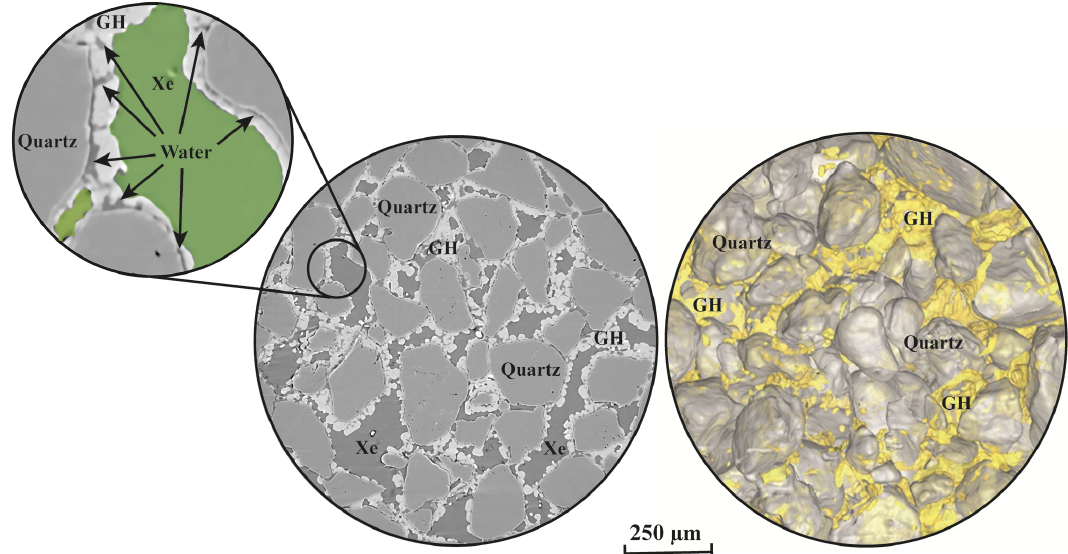
Figure 4. Overview of a 2-D slice in X–Y direction and the equivalent 3-D rendered volume. The presented sample contains 17vol% hydrate. The 2-D slice has a dimension of 2560 × 2560 pixels with a pixel size of 0.76µm 2 . The volume-rendered image depicts the quartz grains in grey and the hydrate in yellow – this dataset is suitable for further model investigations. The zoom-in depicts all the phases present in the samples: xenon – Xe (green), quartz grains, gas hydrate – GH and